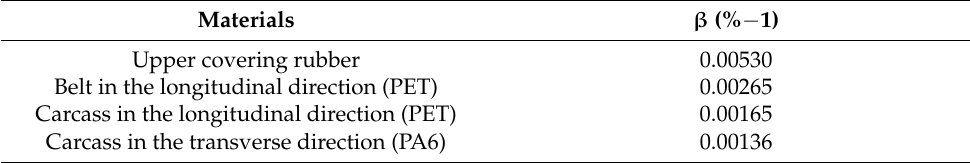
Table 5. Hygric expansion coefficients of materials under water immersion at 50 ◦